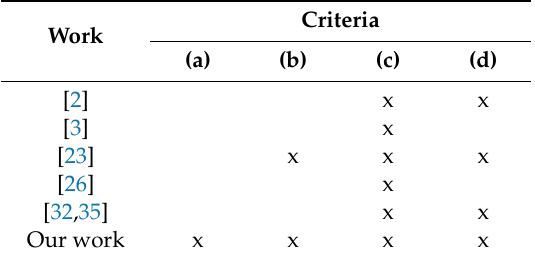
Table 11. Comparison with other